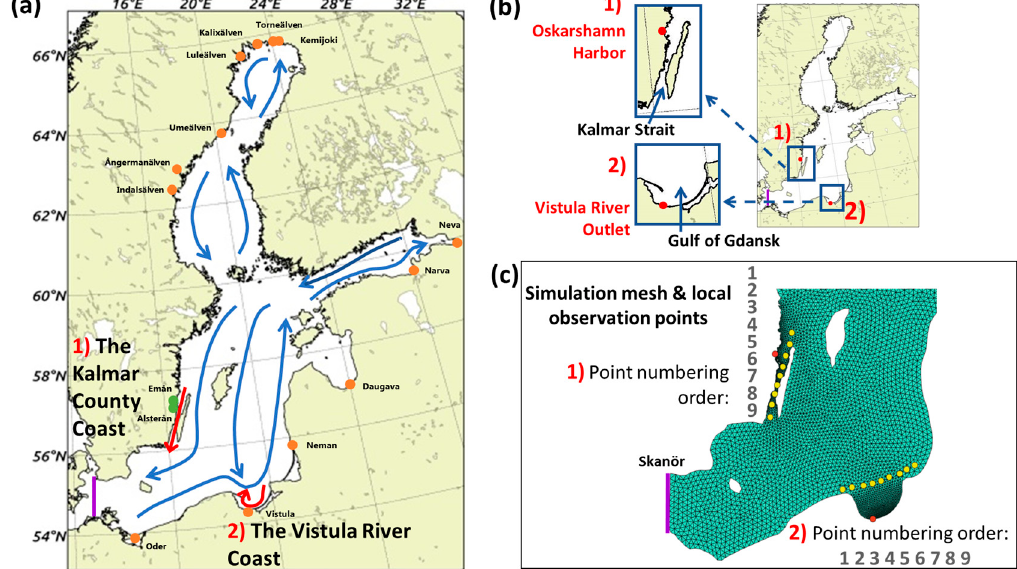
Figure 1. ( a ) The Baltic Sea locations of the (1) Kalmar County and (2) Vistula River coastal cases are shown with the associated main coastal (red arrows) and marine (blue arrows) water flows; orange dots show the locations of the 13 largest river outlets along the whole Baltic coast and green dots show the outlet locations of two relatively small local rivers at the Kalmar coast. ( b ) Focused illustration of the two simulated coastlines and respective solute source release locations (red dots). ( c ) Simulation mesh and local observation points for solute transport results along each coastline (yellow dots, numbered in shown order).